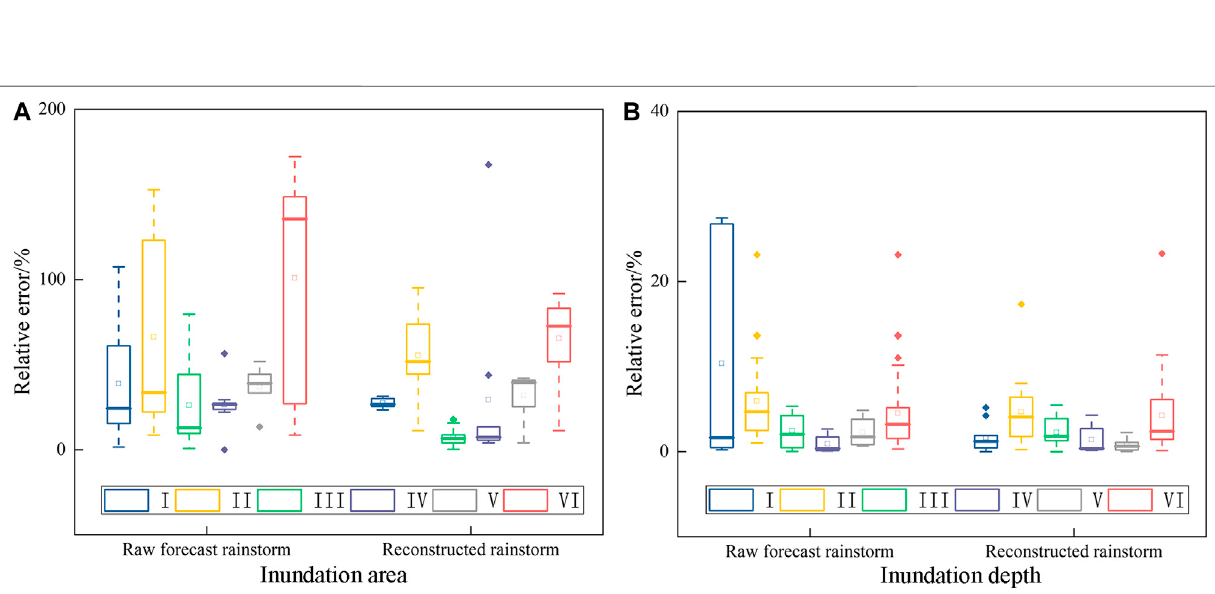
Frontiers in Earth Science |